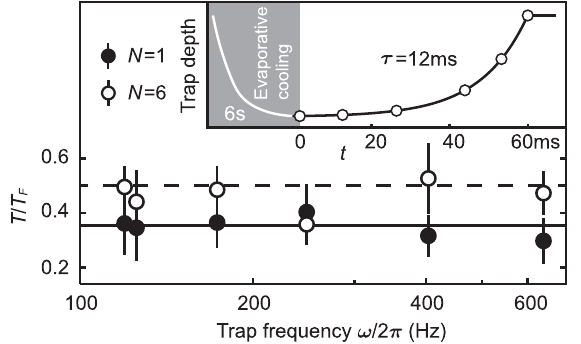
FIG. 6. The ramp-up of the optical dipole trap. T=T F of both noninteracting gases ( N ¼ 1 ) and weakly interacting gases ( N ¼ 6 ) are conserved during ramping up the optical dipole trap. The ODT is increased exponentially in t time constant τ ¼ 12 ms (inset). Gases with N ¼ 1 and N ¼ 6 components are initially prepared at T ¼ 0 . 35 T F and 0 . 5 T F ,